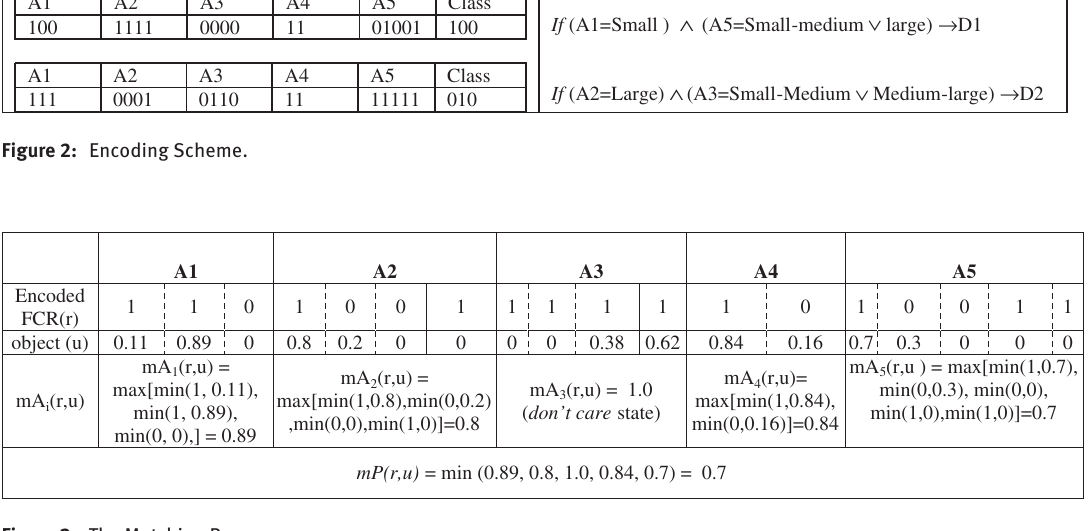
Figure 3: The Matching